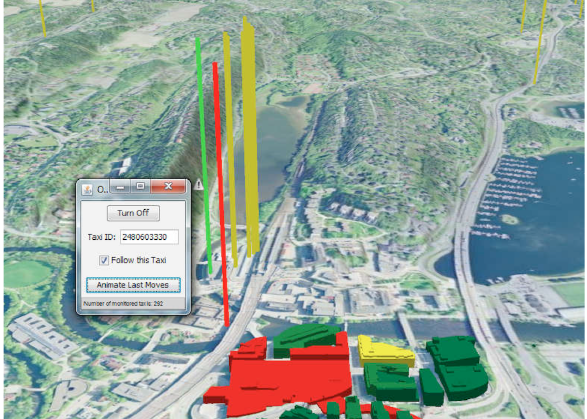
Figure 3. Taxis showing as poles.